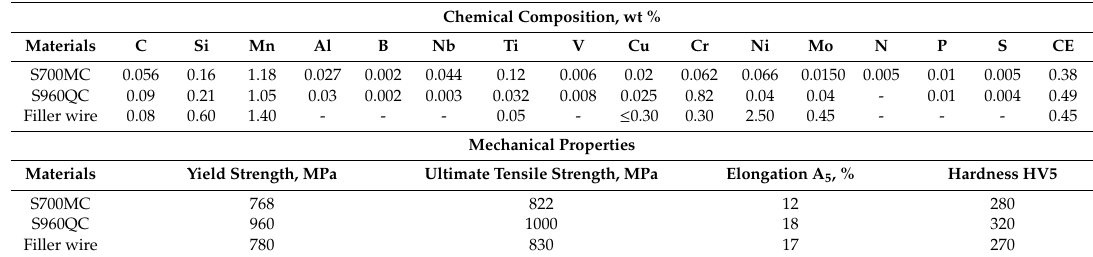
Table 2. Chemical composition and mechanical properties of S700MC and S960QC steels and filler material NiCrMo700. Chemical composition, wt